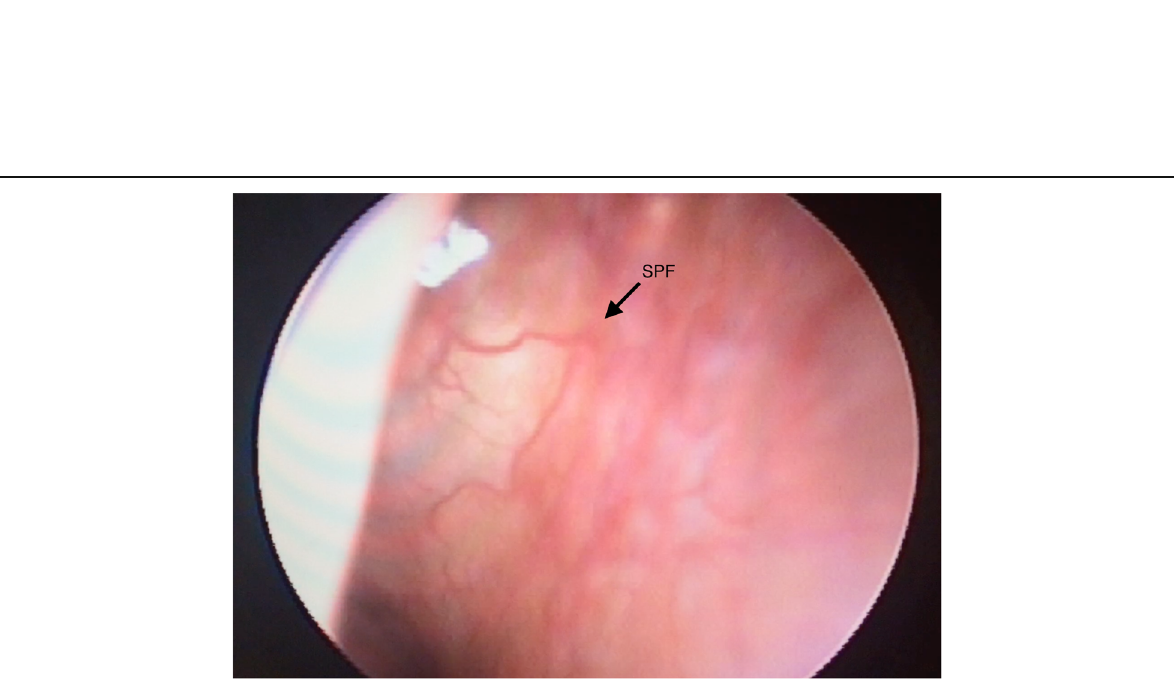
Fig. 3 Rhinoscopy showing the mucosa over the sphenopalatine foramen (SPF) and the sphenopalatine artery (arrow). The SPF does not appear as an open foramen communicating directly with the sphenopalatine fossa. The SPF is covered by mucosa and packed with neurovascular structures and connective